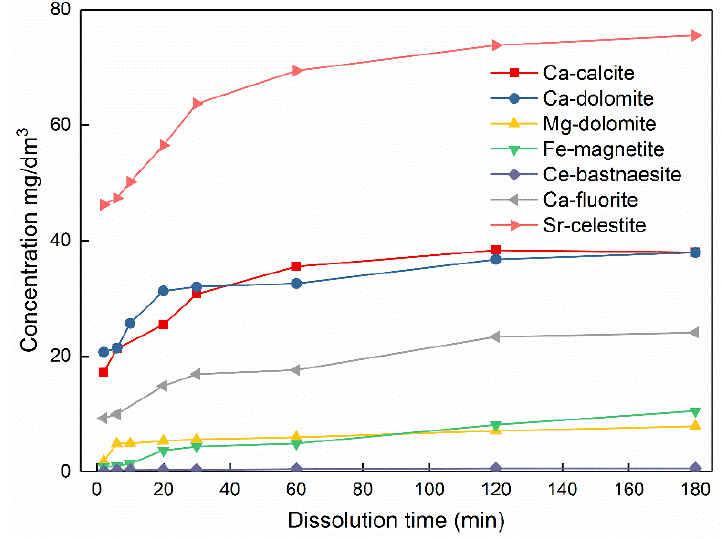
Figure 3. Concentration of metal ions release from minerals.